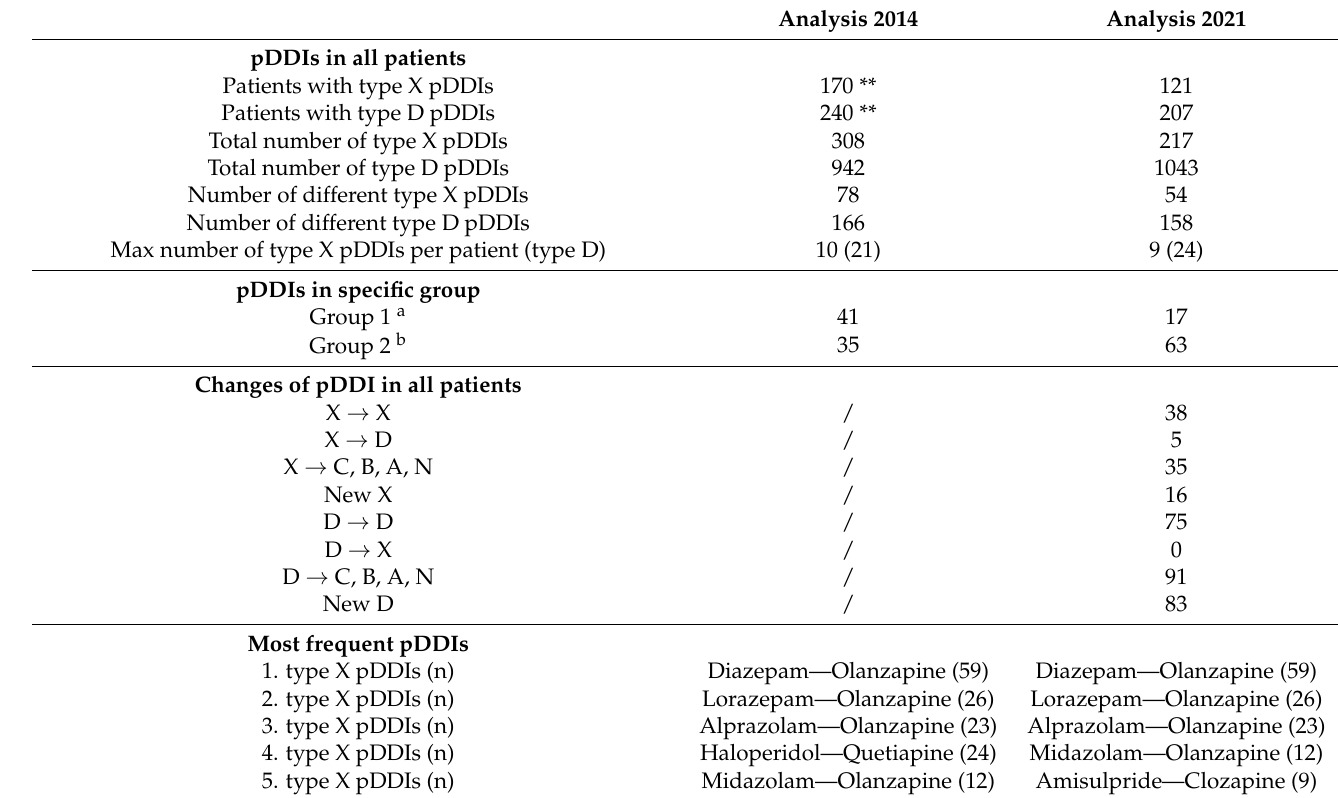
Table 5. Comparison of pDDIs determined using the Lexicomp®drug interaction database program in 2014 and